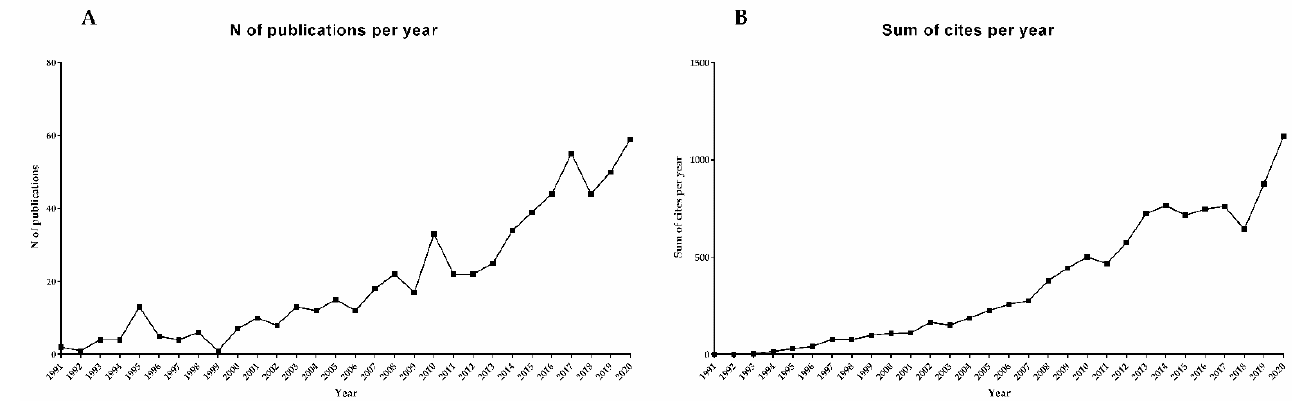
Figure 3. Number of publications and sum of cites per year . ( A ) Time-trend of the number of issues published per year (R 2 = 0.739); ( B ) Time-trend showing the sum of cites per year (R 2 = 0.975).